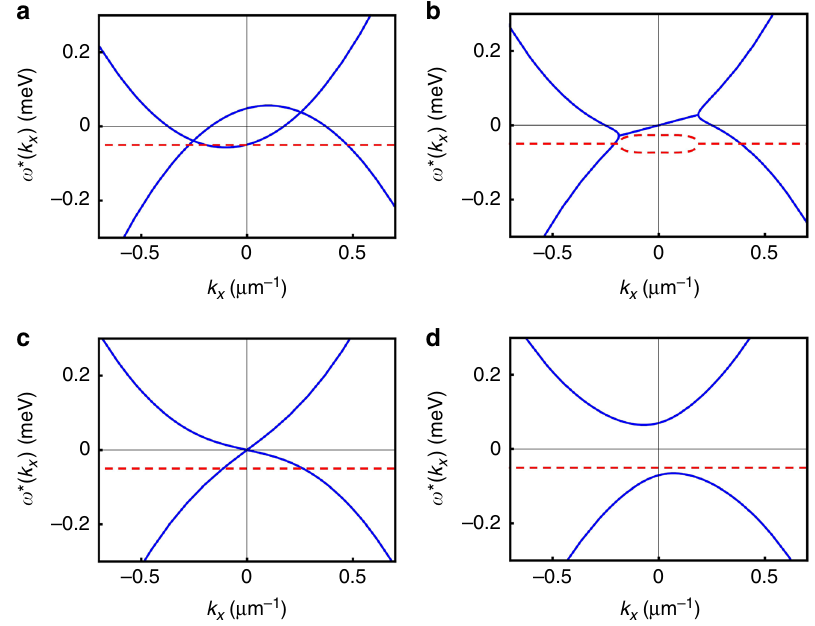
Fig. 2 The excitation spectrum at different polariton densities. The real (solid blue) and the imaginary (dashed red) parts of the spectrum in the frame of the pump momentum, which is k p = 0.1 µ m − 1 in the x -direction, for k y = 0. The pump is blue detuned by 0.05 meV with respect to the bare lower polariton dispersion. In a and b , the densities are | ψ 0 | 2 = 0.2 µ m − 2 and | ψ 0 | 2 = 9.3 µ m − 2 , respectively. In c , the density is | ψ 0 | 2 = 20.0 µ m − 2 and the pump comes into resonance with the interaction shifted lower polariton dispersion, Δ p = ω p − ε 0 − V | ψ 0 | 2 = 0, at which point the real part takes the linear form of the Bogoliubov spectrum. Here, and in d where | ψ 0 | 2 = 30.9 µ m − 2 , the Landau criterion is ful fi lled in the real part. However, it is signi fi cant that the imaginary part is always